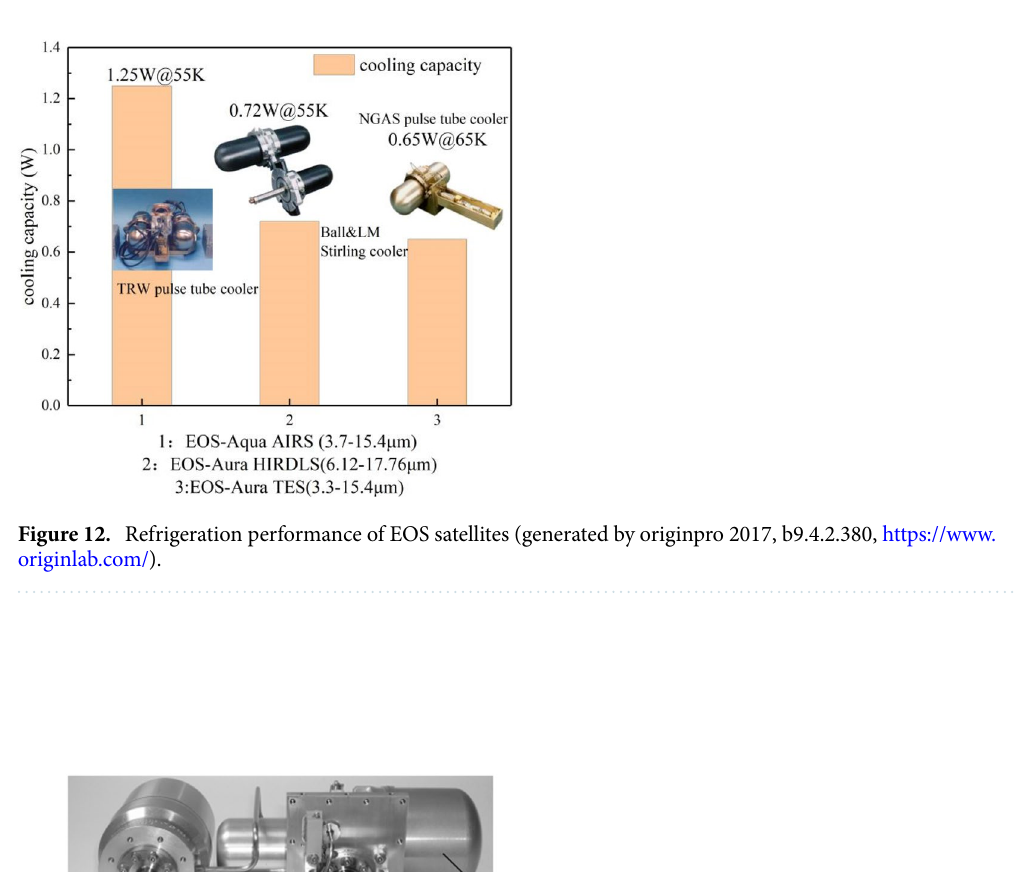
Figure 11. Refrigeration performance parameters in the 90 K detection temperature zone (the left is radiative cooling, the right is mechanical cooling) (generated by originpro 2017, b9.4.2.380, https:// www. origi nlab. com/).